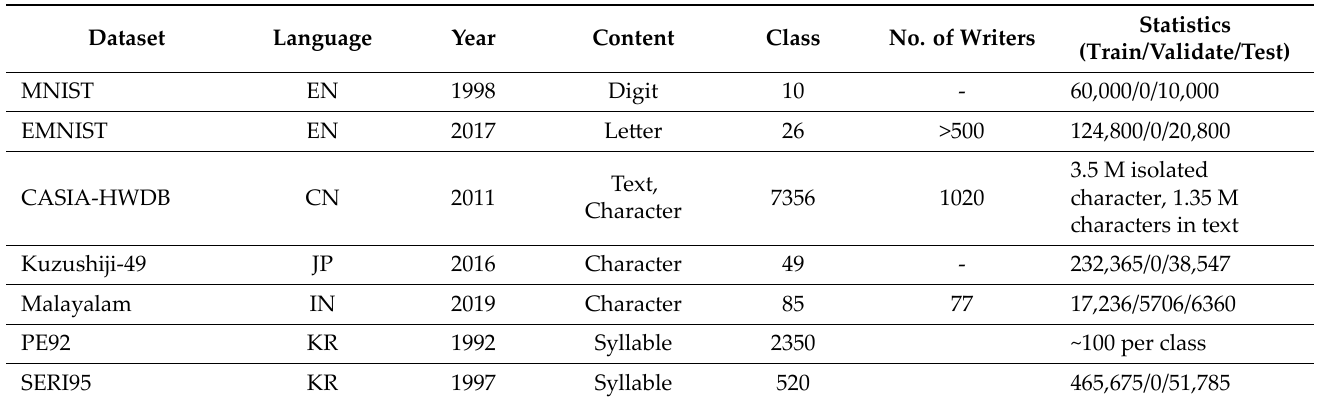
Table 5. A statistics comparison of Burapha-TH datasets and public datasets discussed in the paper.